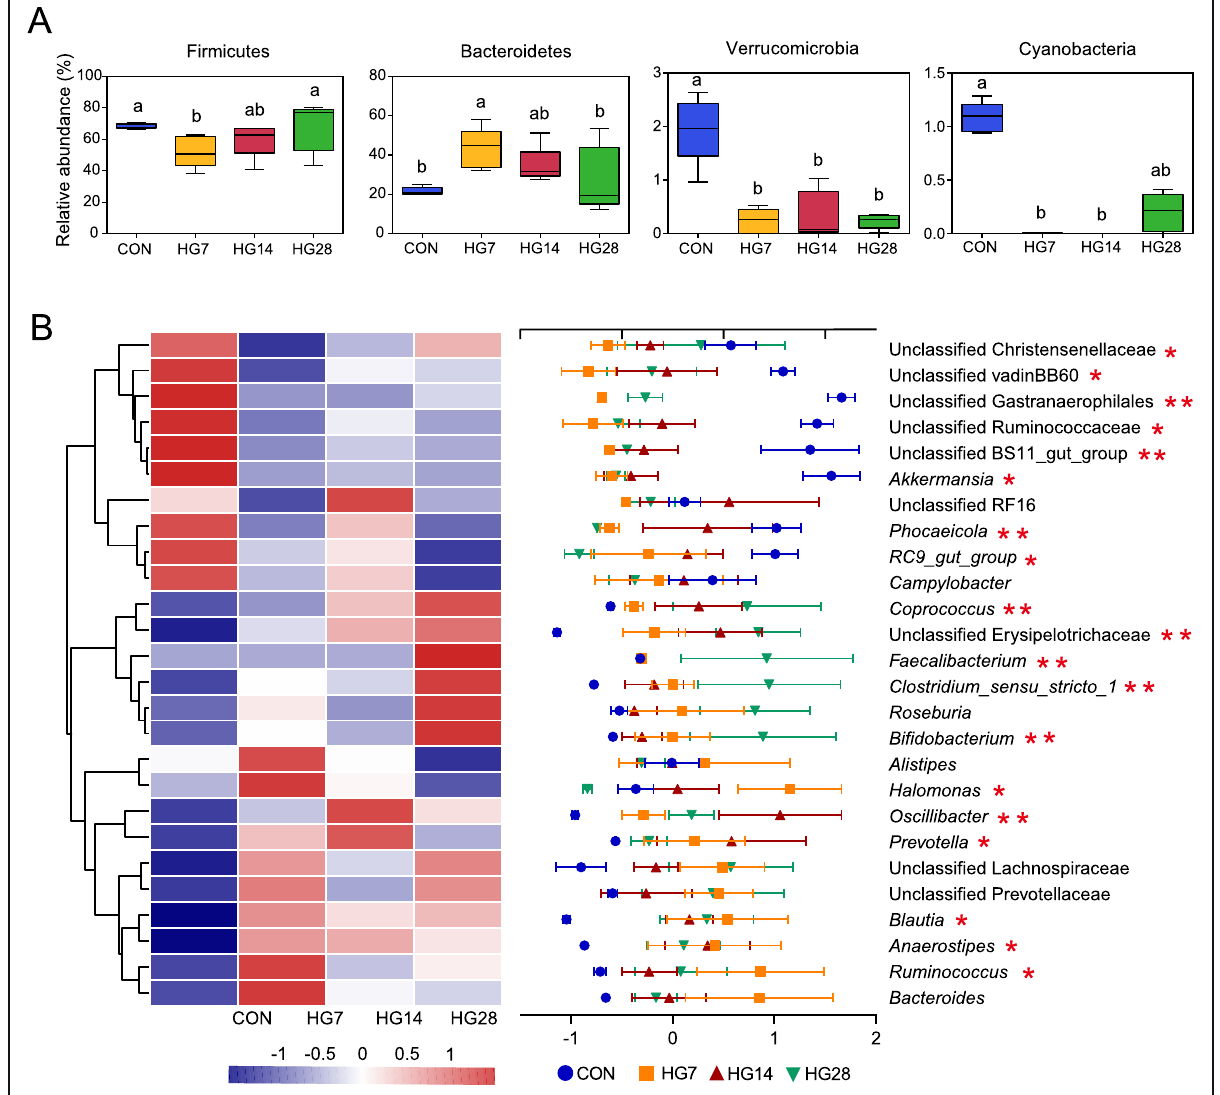
Fig. 2 Dominant phyla or taxa of bacteria that had a relative abundance of more than 1% for at least one group were compared among the four groups. (A) Phylum-level differences in relative abundance among four groups. (B) Distribution of the predominant taxa in colonic digesta. The color key of the heat map depicts the z-score of the relative abundance of the dominant taxa. * p < 0.05, ** p <